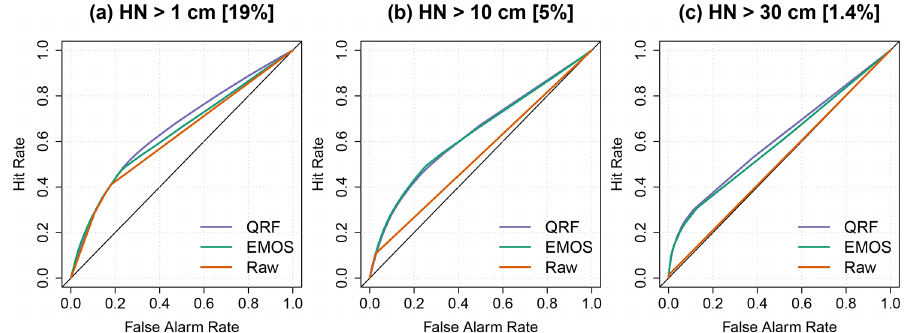
Figure 7. ROC curves for different snow events. (a) HN exceeds 1cm. (b) HN exceeds 10cm. (c) HN exceeds 30cm. Values in brackets indicate the observed frequencies in percent. A sharp prediction system must maximize the hit rate and minimize false alarms.